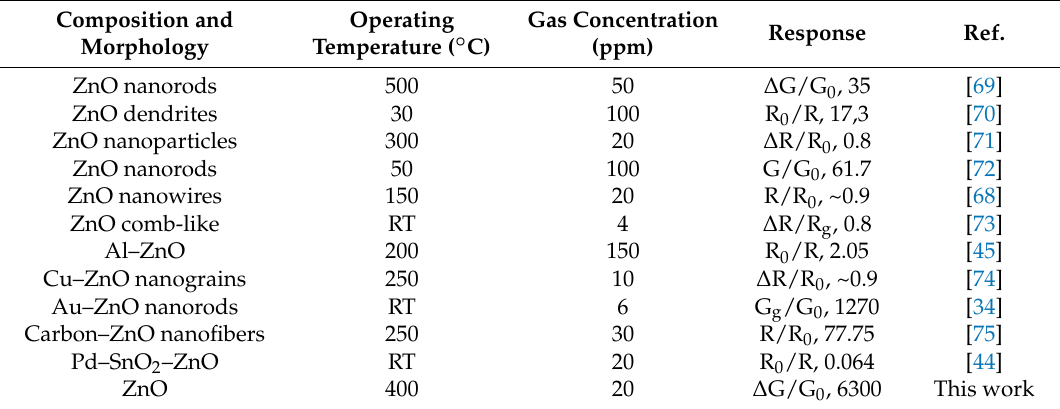
Table 2. Comparison of H 2 S gas sensing properties of the prepared ZnO nanomaterial with the previously reported H 2 S gas sensors based on ZnO. G 0 is the sample conductance in air and G is the sample conductance in the presence of H 2 S. R 0 is the sample resistance in air, R is the sample resistance in the presence of H 2 S.